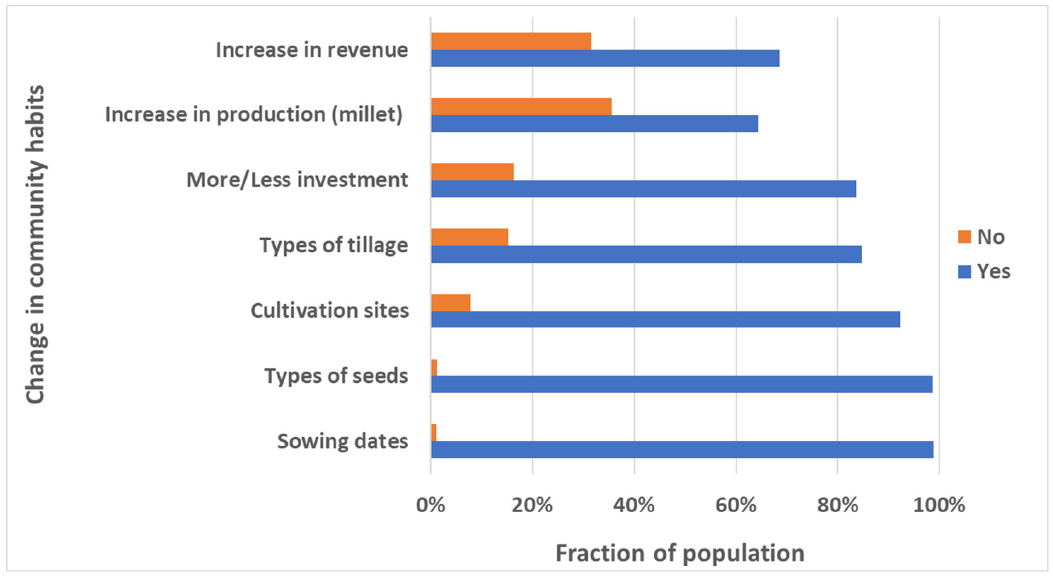
Figure 5. Proportion of people who changed their habits and practices in the surveyed areas.